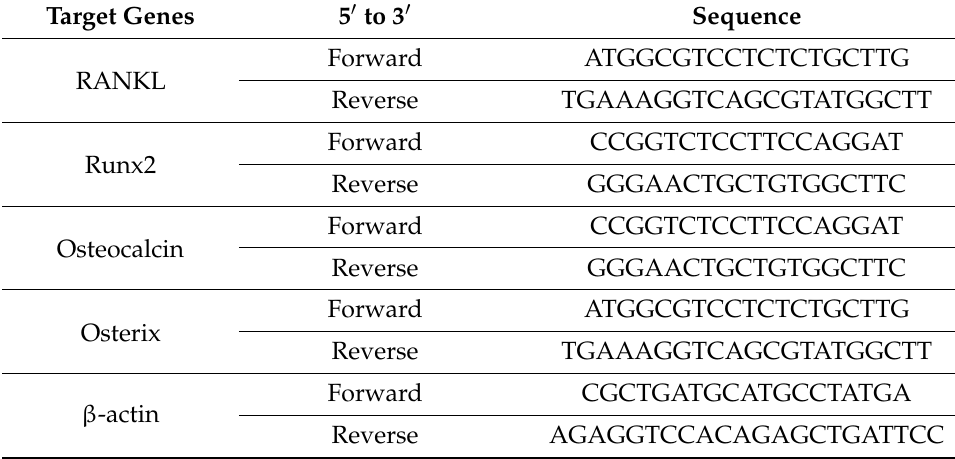
Table 1. Target gene-specific primer sequences. Target